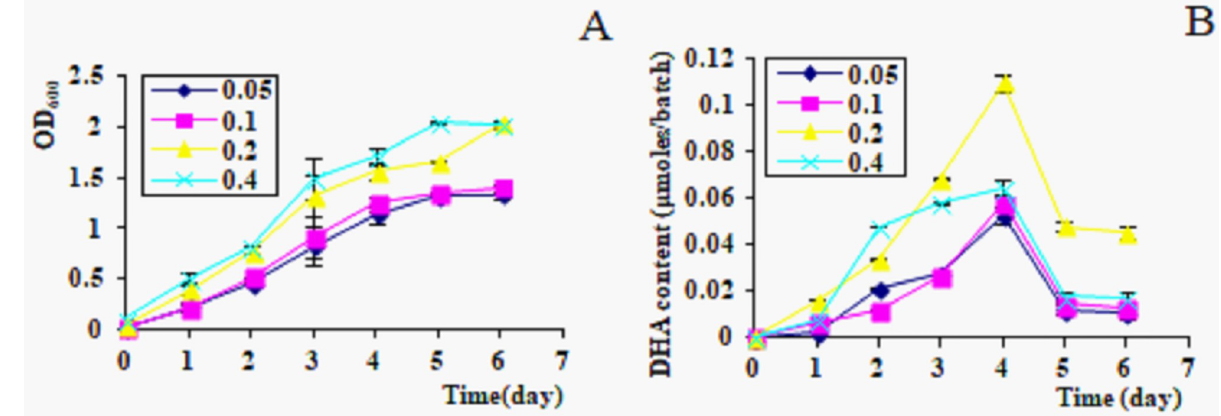
Fig 1. Growth rate and DHA production in different inoculated densities. A. OD 600 ; B, DHA content in culture, 1ml/batch. (Fig 3C). At 30˚C, algal cells grew fast at first, then declined sharply after day 5 (Fig 3A). Glu- cose consumption stopped at 2 g/L after day 5, and DHA production was low (Fig 3B and 3C). 3.1.4 Air/Culture volume ratios. Growth rate of algal cells was highest in 9:1 and 4:1 air/ culture volume ratios. Glucose consumption stopped on days 3–7. DHA production reached the highest level on day 4. In 1.5:1 air/culture volume ratio, both growth rate and DHA yield were the lowest, and glucose consumption stopped on days 5–7 (Fig 4A–4C).